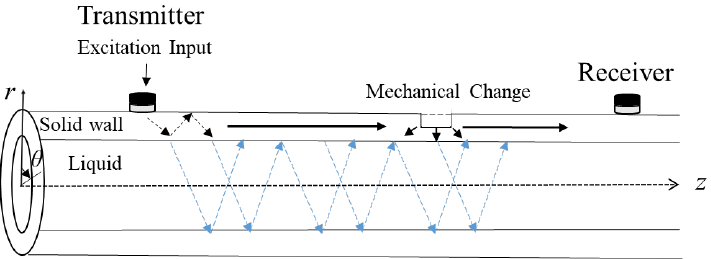
Figure 1. Schematic illustration of the multi-mode guided and liquid-mediated waves propagating in a liquid-filled pipe.